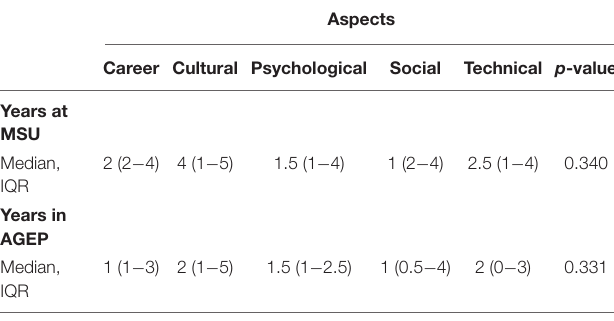
TABLE 6 | Response analysis from important aspects open-ended question.